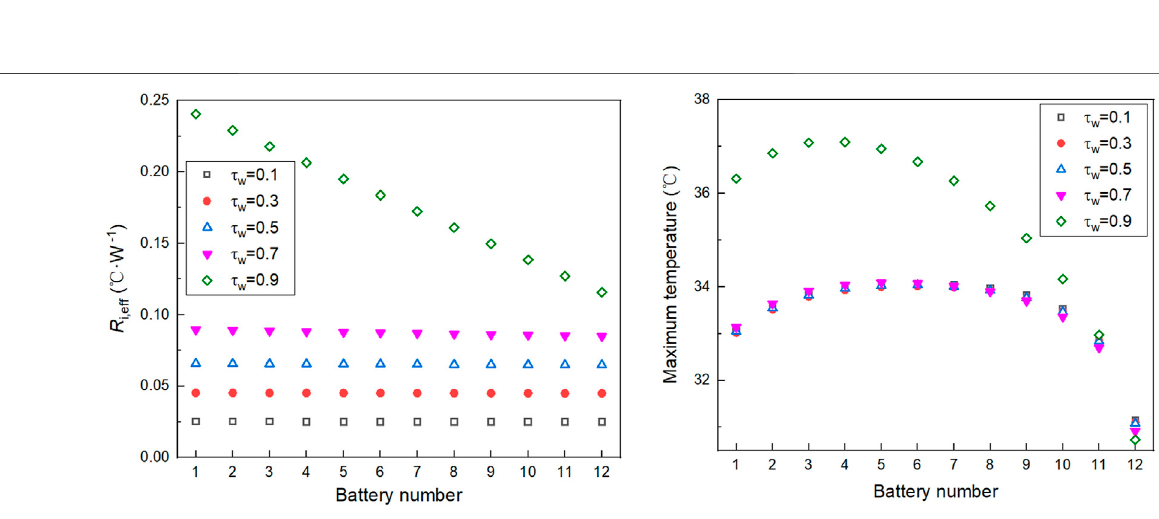
Frontiers in Energy Research |